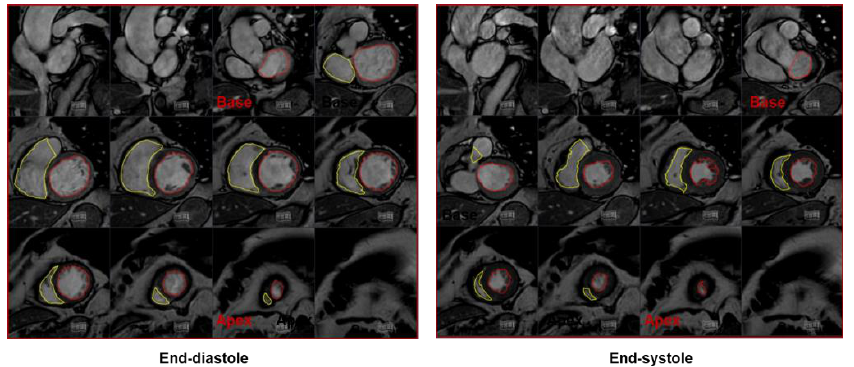
Figure 3. Cardiac magnetic resonance calculation of the left ventricular (LV) ejection fraction (EF): a stack of short-axis cine images covering the entire left ventricle from the atrioventricular ring to the apex. LV (red) and right ventricular (yellow) endocardial contours are drawn in end-diastole and end-systole to measure LV volume and LVEF.